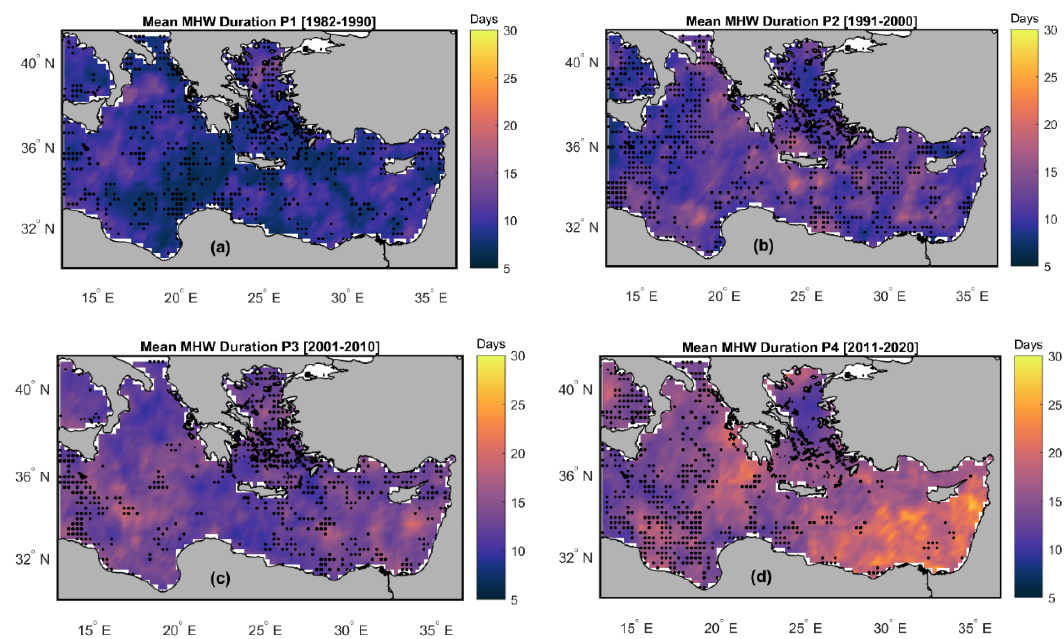
Figure 8. The EMED MHWs mean duration (days) for ( a ) P 1 (1982–1990), ( b ) P 2 (1991–2000), ( c ) P 3 (2001–2010) and ( d ) P 4 (2011–2020), and the black dots indicate the change is not significantly different ( p > 0.05).